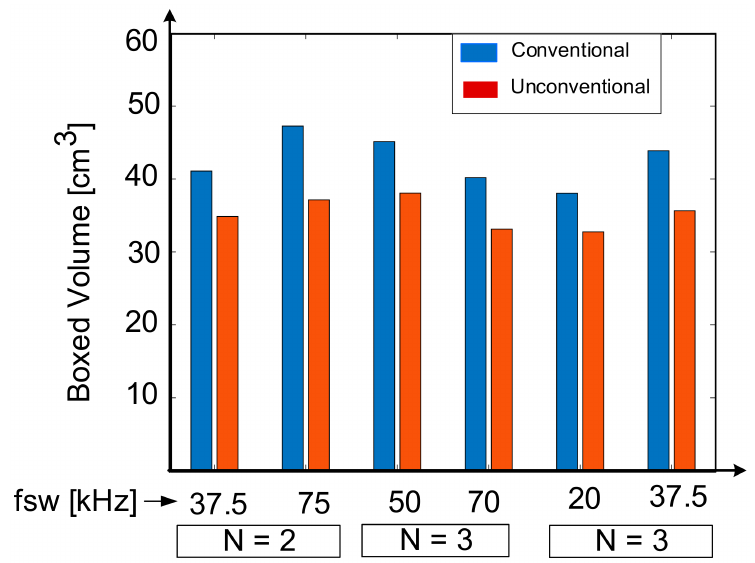
Figure 11. Optimal DM EMI filter boxed-volume approximation including conventional and uncon- ventional phase shift in Band b based on Table 3 and flowchart in Figure 10.